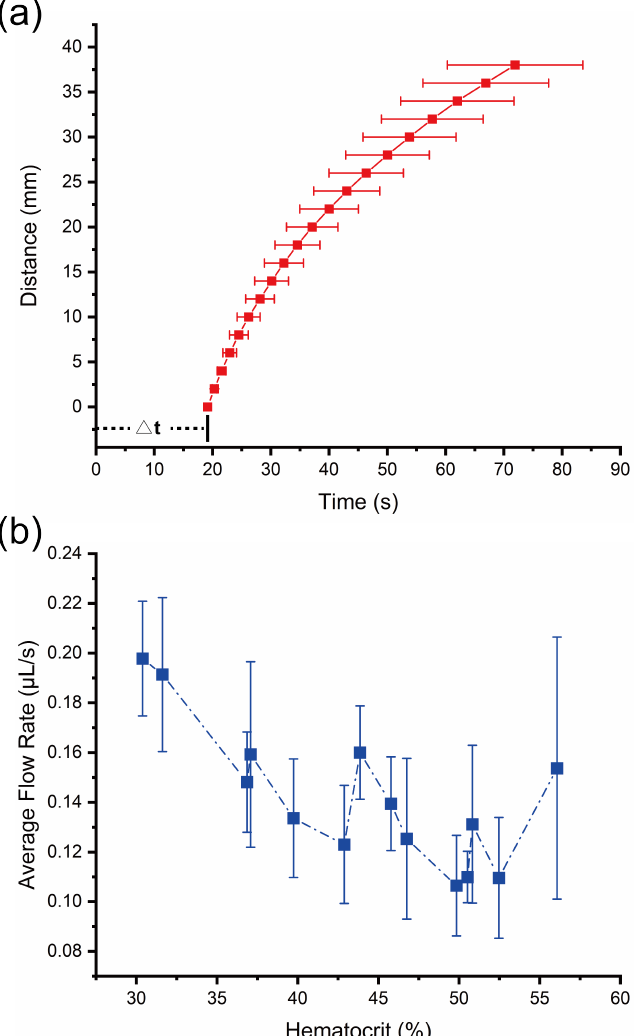
Figure 4. The flow behavior of different blood samples on the devices. We tested 14 blood samples on the devices, and these blood samples have hematocrit values from 30.4% to 56.1%. ( a ) The average distance–time curve of different blood samples: the average ∆ t for these 14 samples is 19.15 s. ( b ) The relation between hematocrit value and average flow